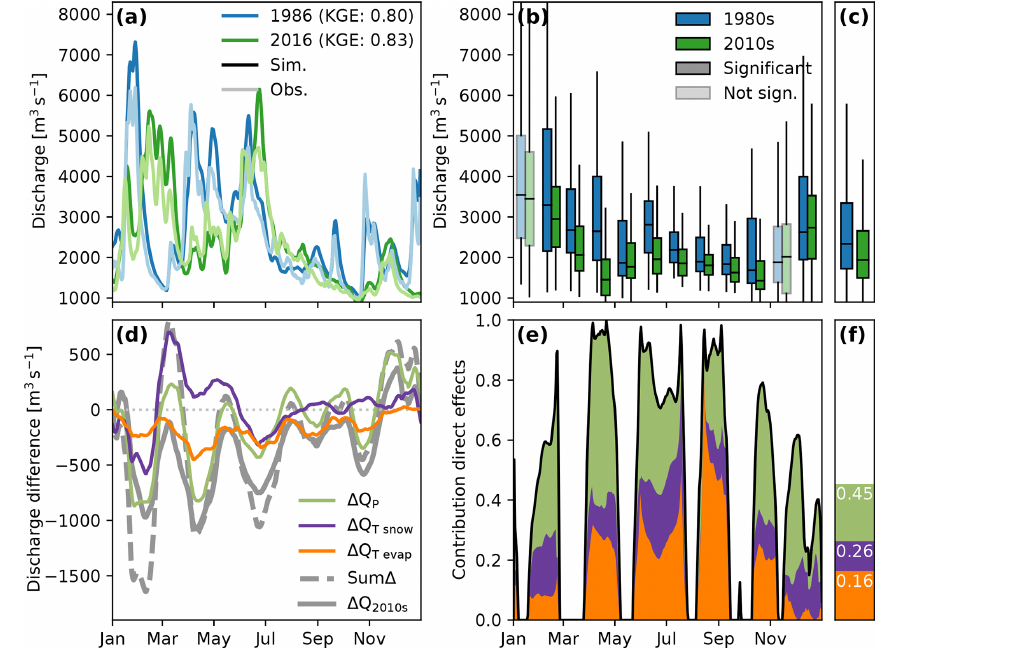
Figure 3. Attribution of discharge changes between the 1980s and the 2010s. Panel (a) compares simulated (dark colours) with observed (light colours) discharge values for 1 representative year in each period. Panels (b) and (c) compare the monthly and yearly (respectively) simulated discharge values between the two periods, where fully coloured boxes are significantly different ( p < 0 . 05, based on independent t test). Panel (d) shows the difference of model simulations where one of the forcing time series of the 1980s has been swapped with the time series from the 2010s. Panel (e) shows the contribution of direct effects (black line) and the contribution of each forcing variable to the total change between the two periods. Overall mean values of the time series in (e) are presented in (f)